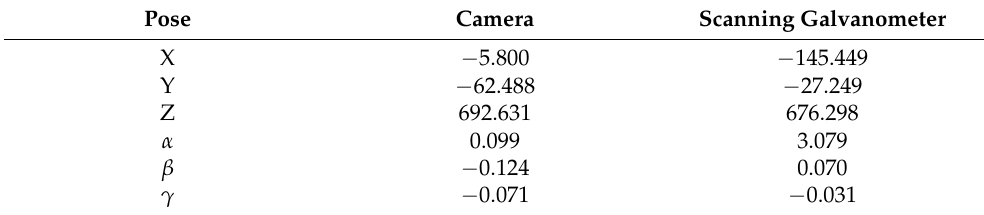
Table 6. Pose information solved by camera and scanning